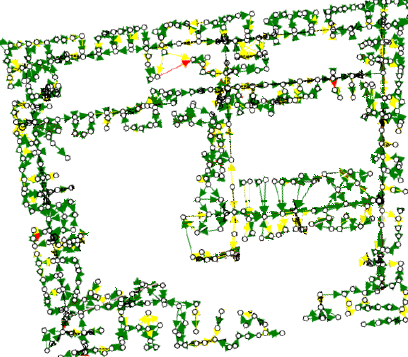
Figure 10. Registered stations of the first level